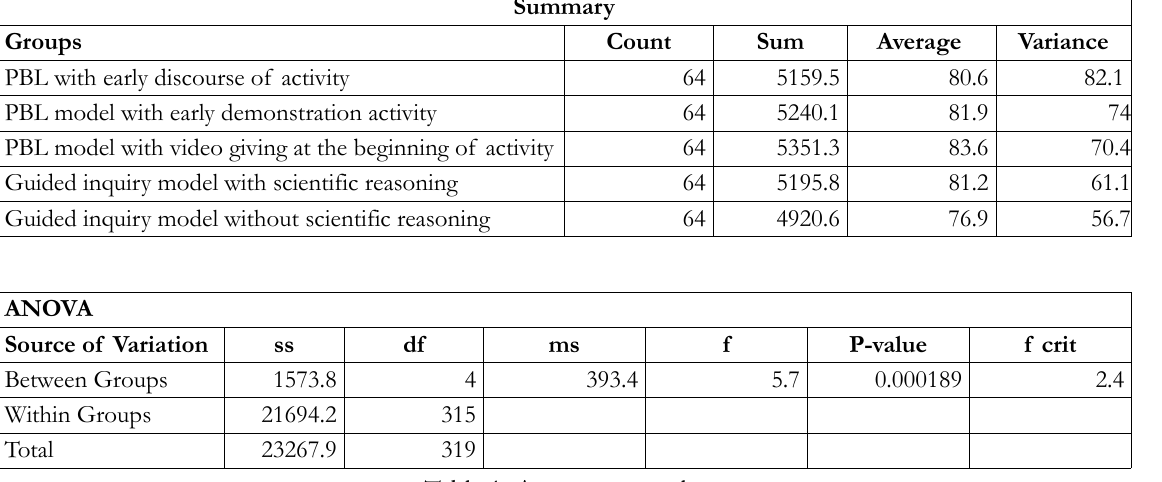
Table 1. Anova test results